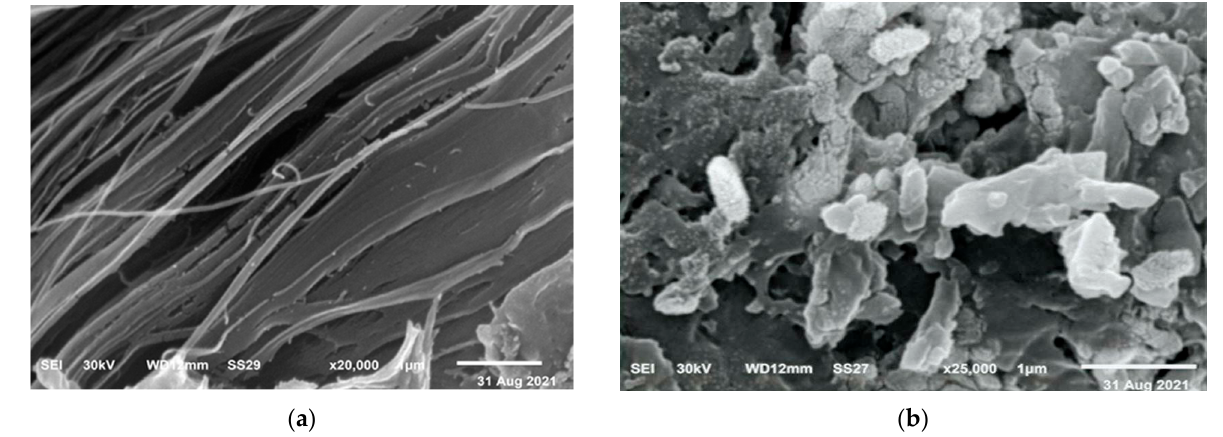
Figure 2. Scanning electron microscopic (SEM) image of biosynthesis: nanocellulose ( a ) and Ag/cellulose nanocomposites ( b ) derived from U. lactuca .